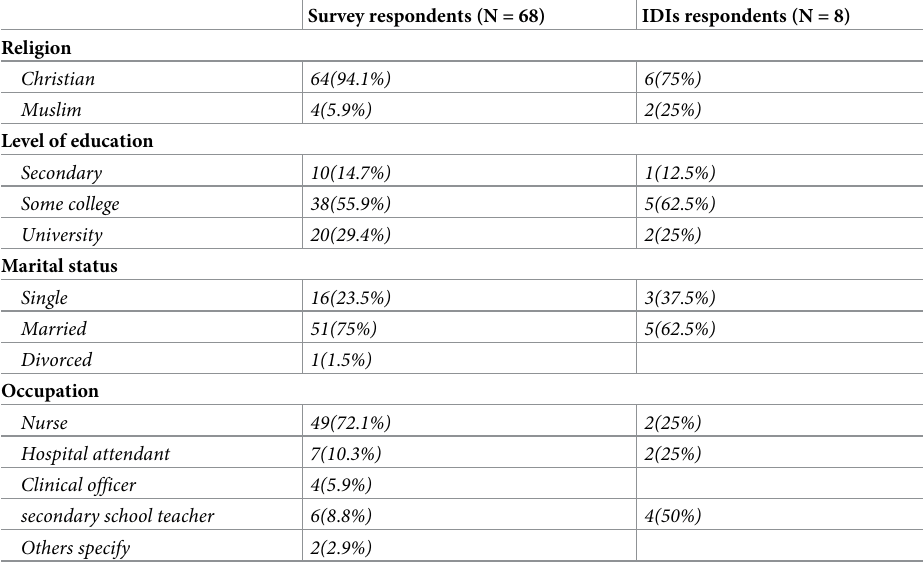
Table 2. Demographic characteristics of survey and interview